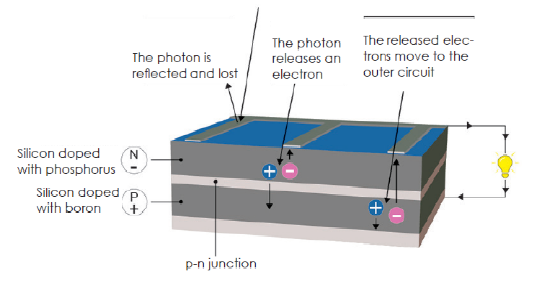
Fig. 1. Random Forest Regression